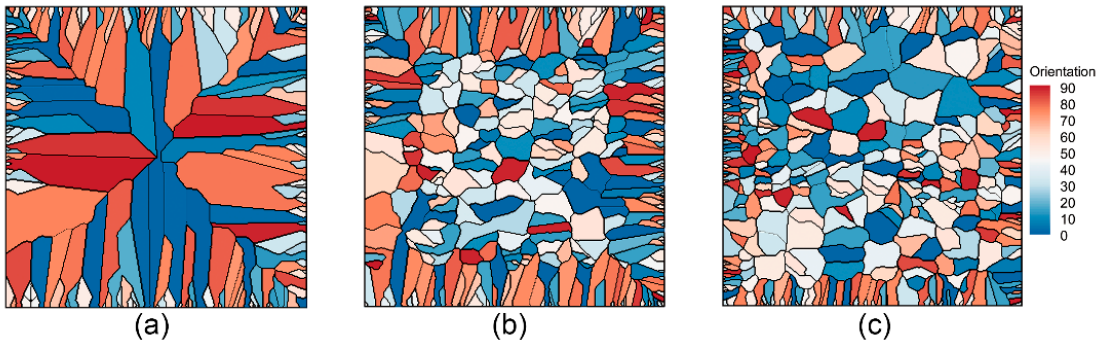
Figure 6. Grain structure of the Al-7 wt% Si specimen with the mean volumetric nucleation undercooling of ( a ) 10 K; ( b ) 8 K; ( c ) 6 K. To verify the grid independence of the CA model, a domain with a size of 24 × 24 mm 2 was used for simulation. The mean volumetric nucleation undercooling was 4 K to ensure large ratio of equiaxed grains’ nucleation. The cell size of 15 µ m, 20 µ m and 25 µ m were selected. Other parameters are the same as the aforementioned condition. The grain area size distribution of each case is shown in Figure 7a. The cumulative grain area size distribution of each case is shown in Figure 7b for comparison. In Figure 7a, results of the three cases show that the grain area size mainly ranges from 0.2 × 10 5 µ m 2 to 1.0 × 10 5 µ m 2 . The cumulative grain size distributions of the cases were consistent with each other and Figure 7b clearly shows that the grain size distributions of cases with cell size of 15 µ m and 20 µ m are almost the